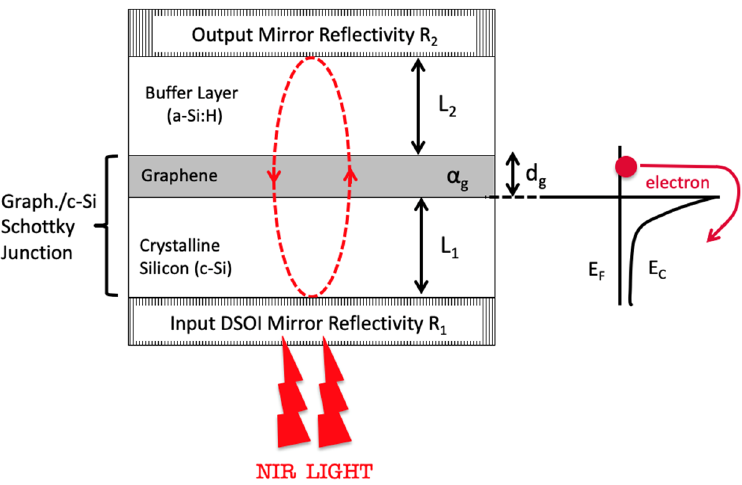
Figure 2. Simplified model of the proposed Fabry–Pérot graphene/silicon Schottky photodetector.